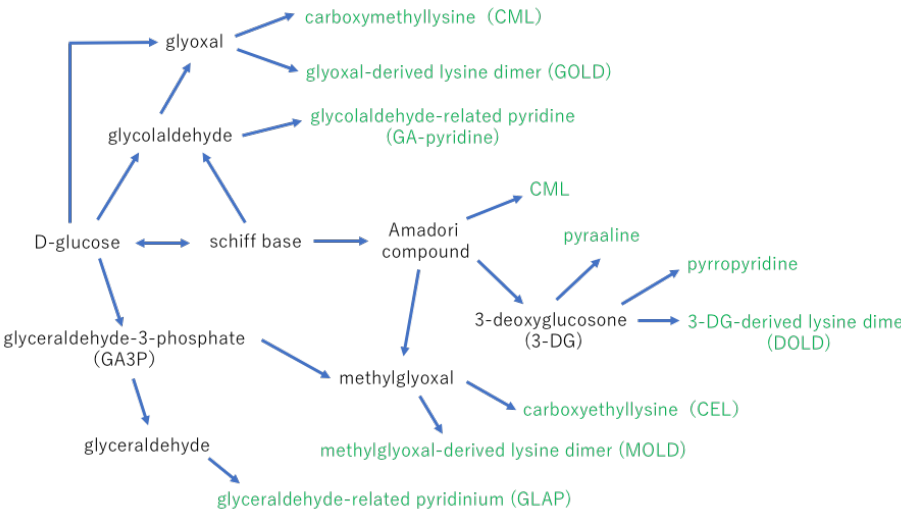
Figure 2. Hypothetical schemes of the final step of AGE formation. Carboxymethyllysine (CML) is synthesized from an Amadori compound or glyoxal [23]. Carboxyethyllysine (CEL) is made from methylglyoxal [24]. Glyoxal-derived lysine dimer (GOLD), methylglyoxal-derived lysine dimer (MOLD), and 3-DG-derived lysine dimer (DOLD) have cross-links between lysine residues and glyoxal, methylglyoxal or 3-DG [25]. Only a small percentage of AGEs in the body have been identified. Glyceraldehyde- and glycolaldehyde-derived AGEs may be synthesized faster than Amadori compound-derived AGEs and more toxic than other types of AGEs.